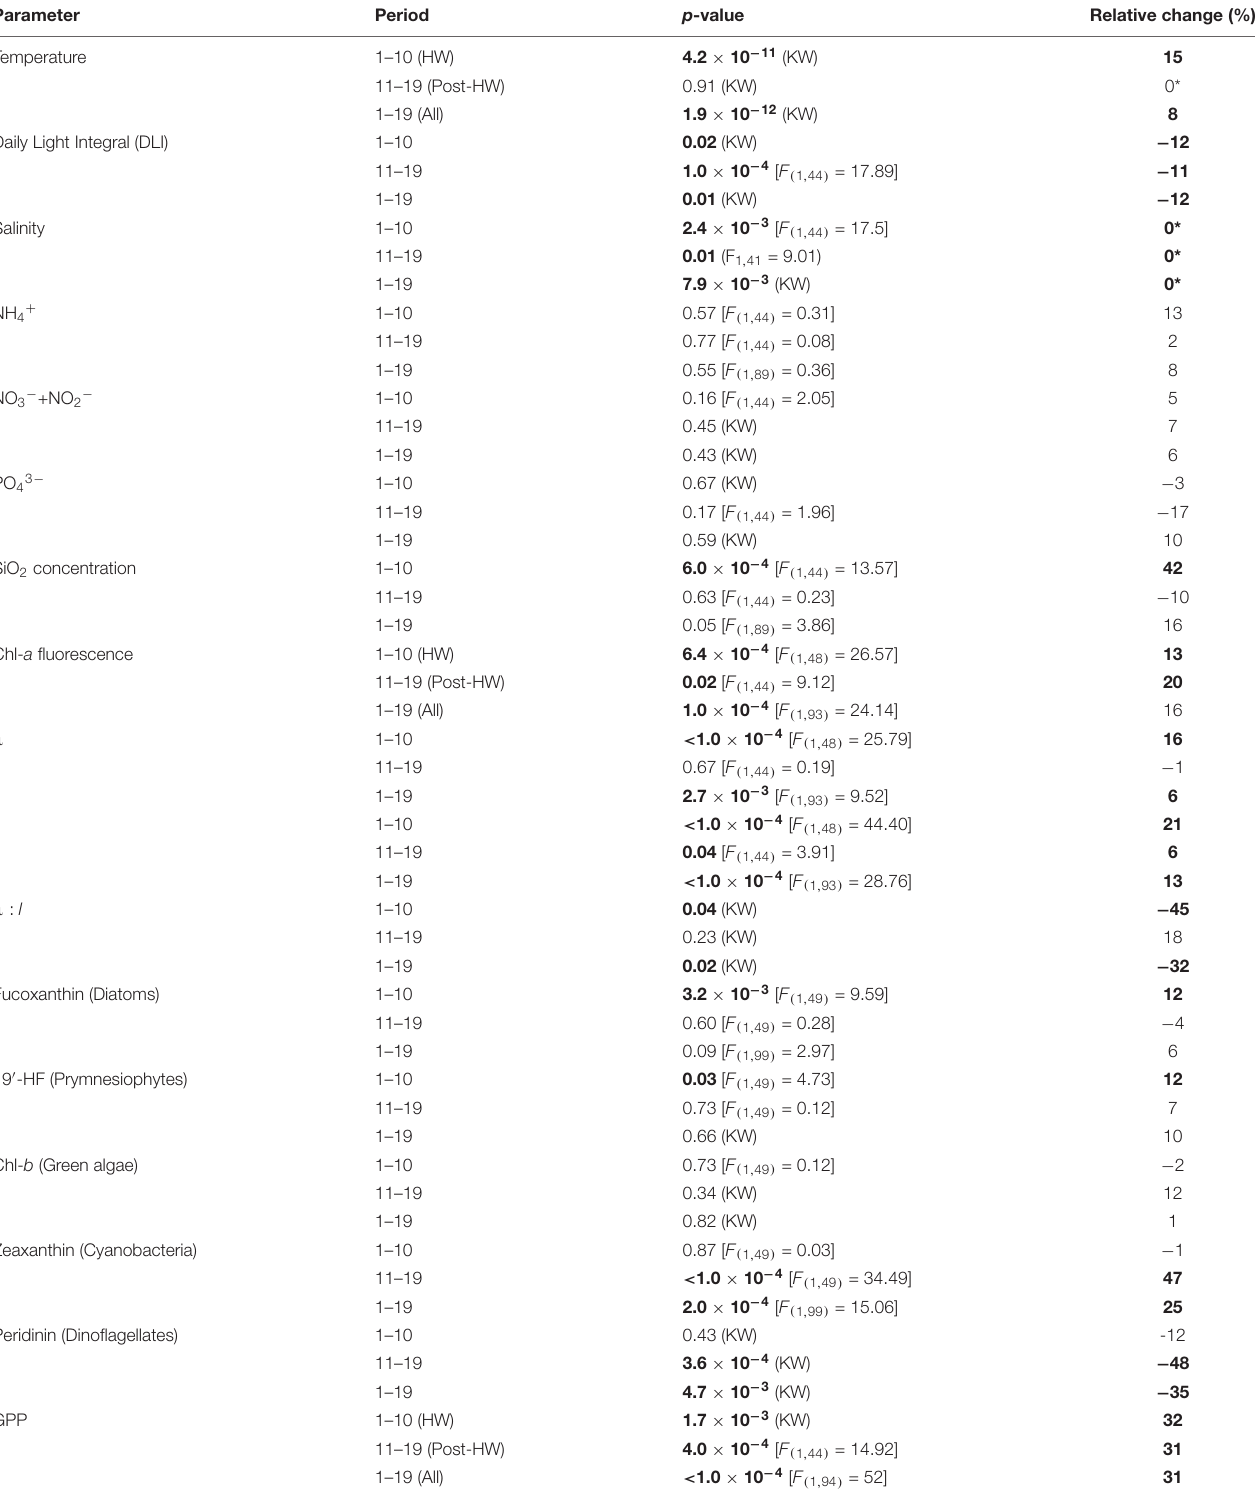
TABLE 3 | Summary table of statistical test results and relative changes between the HW and control treatments in physical, chemical, and biological parameters during the HW period, post-HW period, and during the entire experiment. Parameter